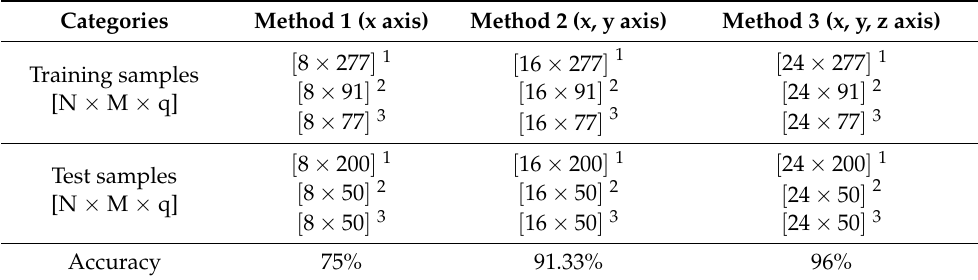
Table 4. Three methods and